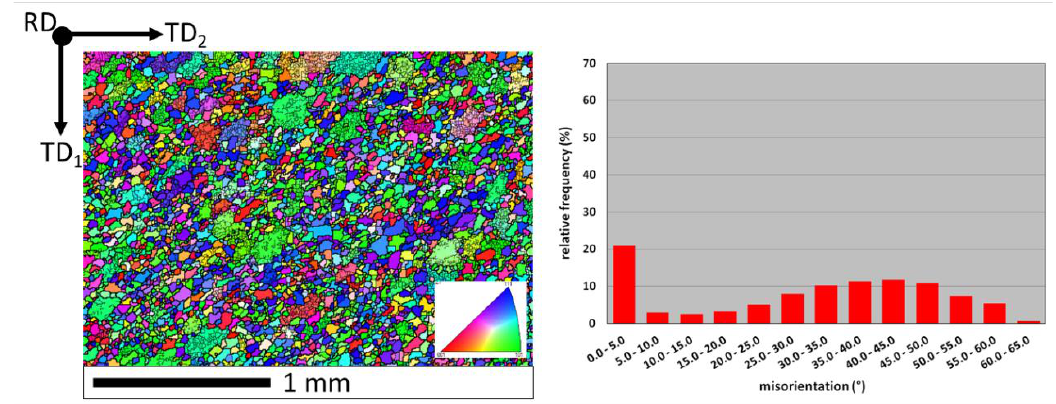
Figure 4. Orientation map and misorientation distribution for FeAl alloy after hot rolling: thick lines — HABs (misorientation > 15°); thin lines – LABs (misorientation < 15°); color interpretation according to the stereographic triangle (red <001> direction, green <110> direction, blue <111> direction); TD 1 , TD 2 — orthogonal transverse directions; RD — rolling direction.